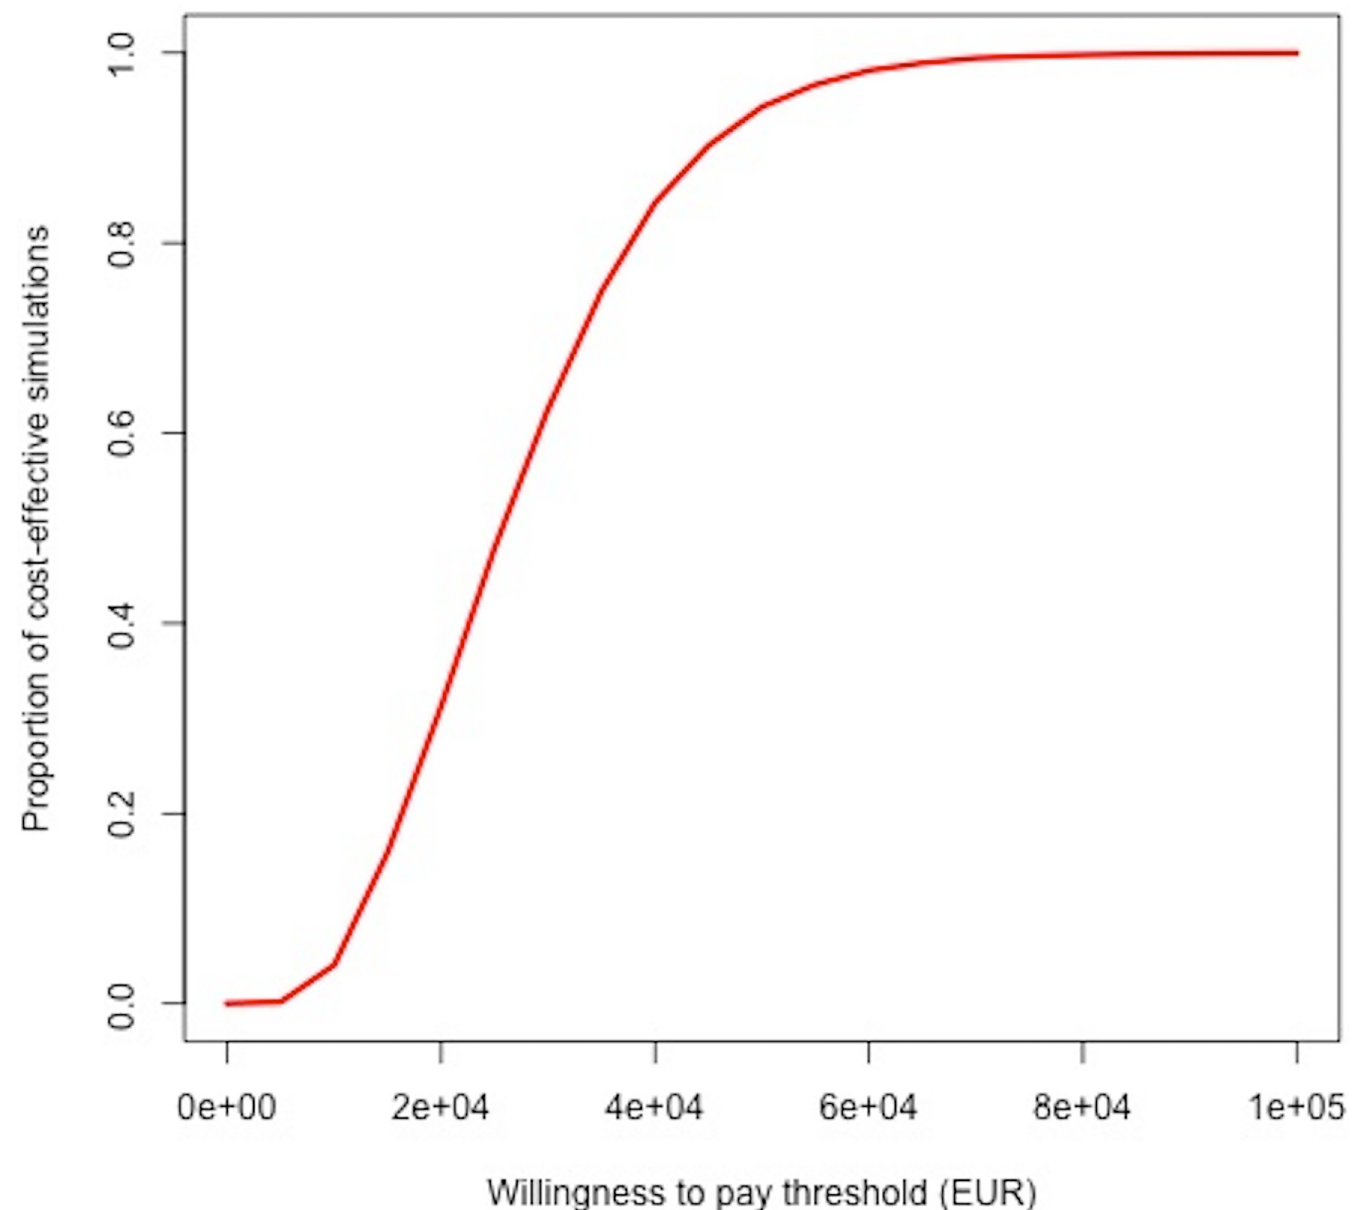
Fig 2. Cost-effectiveness acceptability curve for early (versus delayed) ART initiation. The y-axis represents the proportion of all simulations that were shown to be cost-effective in the probabilistic uncertainty analysis under different willingness-to-pay thresholds, expressed as 2017 euros per QALY gained (on the x-axis). At current proposed WTP thresholds of € 30,000 per QALY averted, 62% of simulations are cost-effective (dashed blue lines). Increasing the WTP to € 80,000 increases the proportion of cost-effective simulations to 99%.